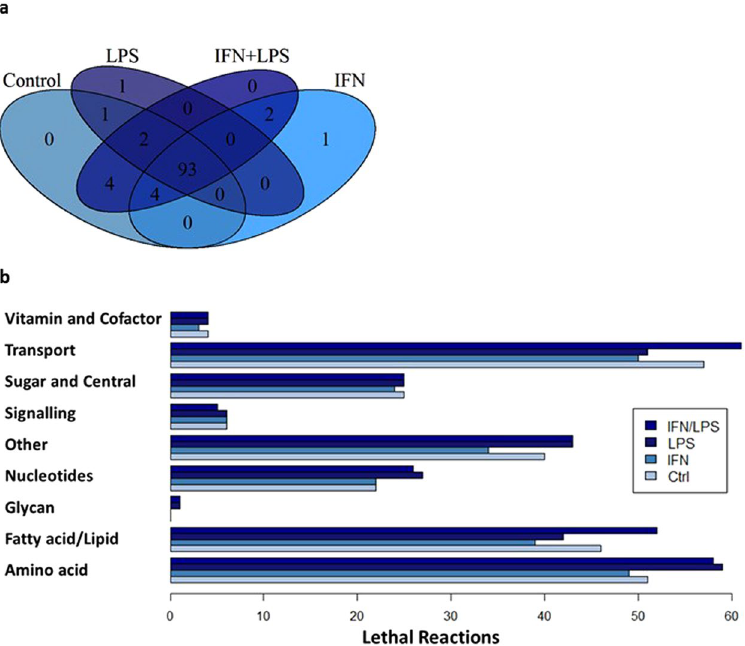
Figure 6. Gene and reaction essentiality in cell culture. ( a ) The shared and unique essential genes of the four cell culture context specific models. ( b ) The distribution by super subsystem of essential reactions in the four context specific